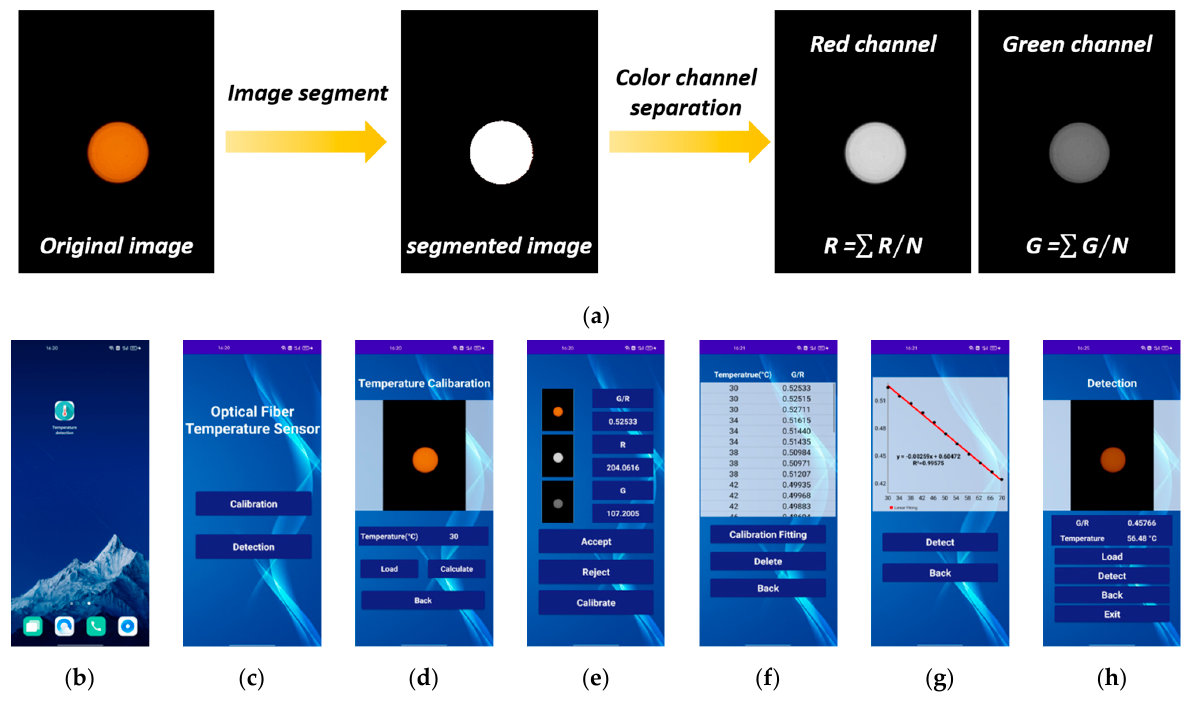
Figure 3. Smartphone application. ( a ) Flow chart of processing of fluorescence image; ( b ) application icon on the smartphone desktop; ( c ) initial interface of application; ( d ) fluorescence image loading interface; ( e ) calculation interface; ( f ) calibration data logging interface; ( g ) calibration result inter- face; ( h ) detection interface. ( h ) detection